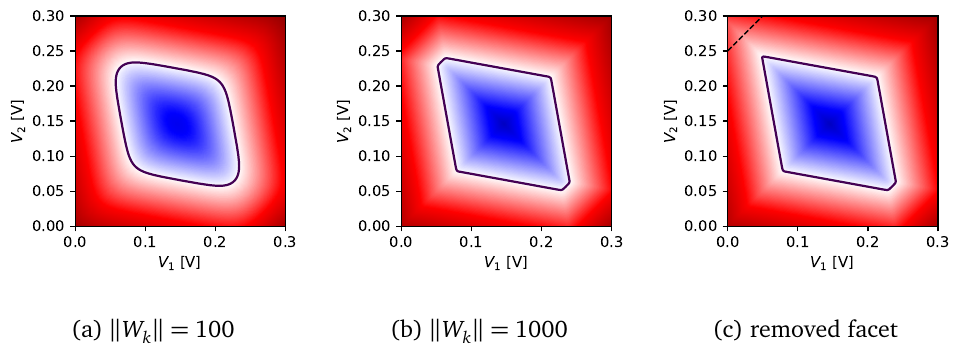
Figure 3: Visualization of classifier h ( v ) for several choices of model parameters. Black lines indicate the contour h ( v ) = 0 while blue (red) pixels indicate h ( v ) < 0 ( h ( v ) > 0). Figures a) and b) use scaled parameters of W of the (1,1) state of a simulated double dot. Parameters are scaled such that the (cid:107) have fixed values. For small norms in a), h ( v ) = 0 has a rounded shape, norms (cid:107) W k while for larger norms in b) the shape h ( v ) = 0 approximates the underlying convex polytope well. Figure c) demonstrates the removal of a facet by moving it outside the polytope (dashed